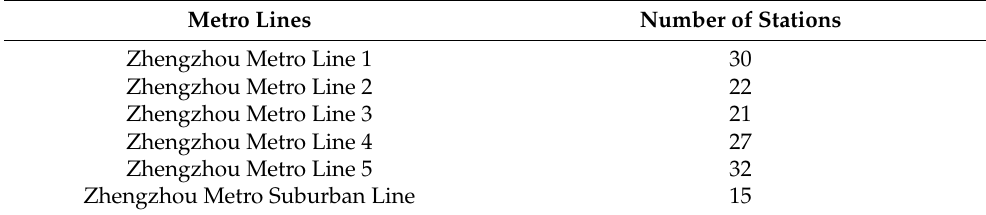
Table 1. Number of metro lines and stations. Metro